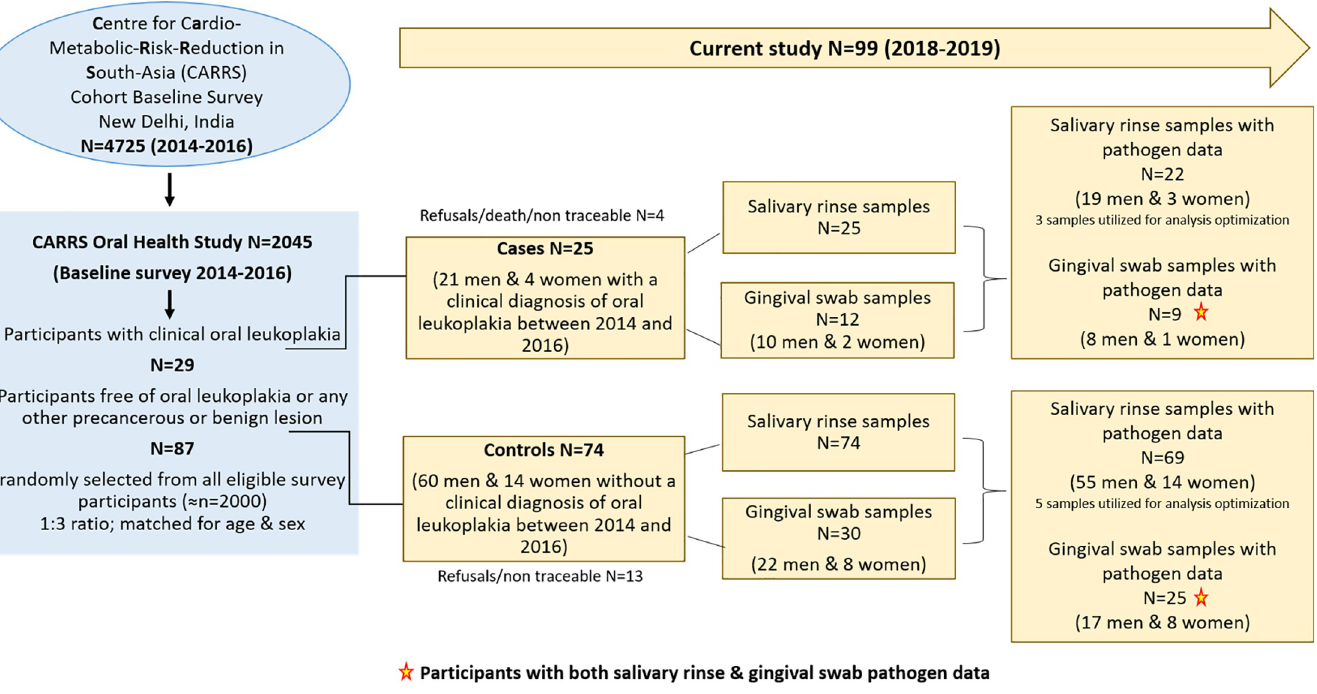
Fig 1. Details of study participants, salivary rinse and gingival swab samples and pathogen data.